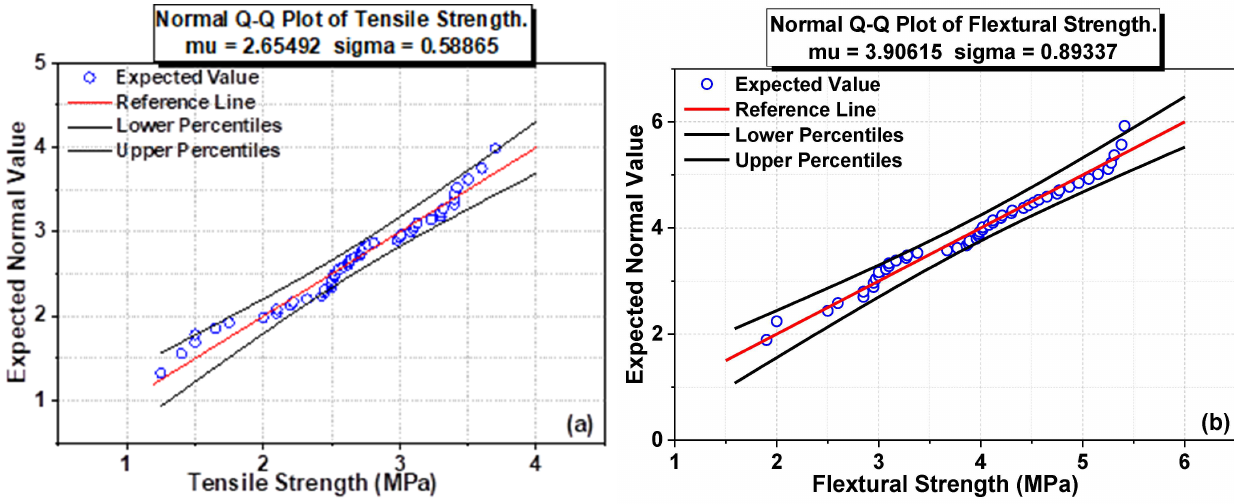
Figure 8. Normal Q-Q plot for ST ( a ) a nd FS ( b